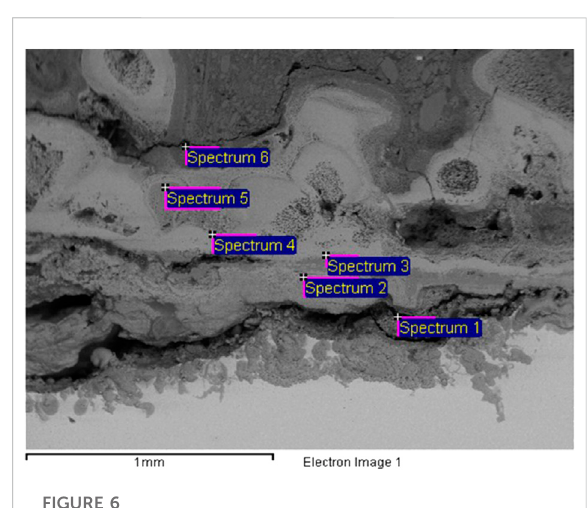
FIGURE 6 Image of the cross-section of the deposition inside the